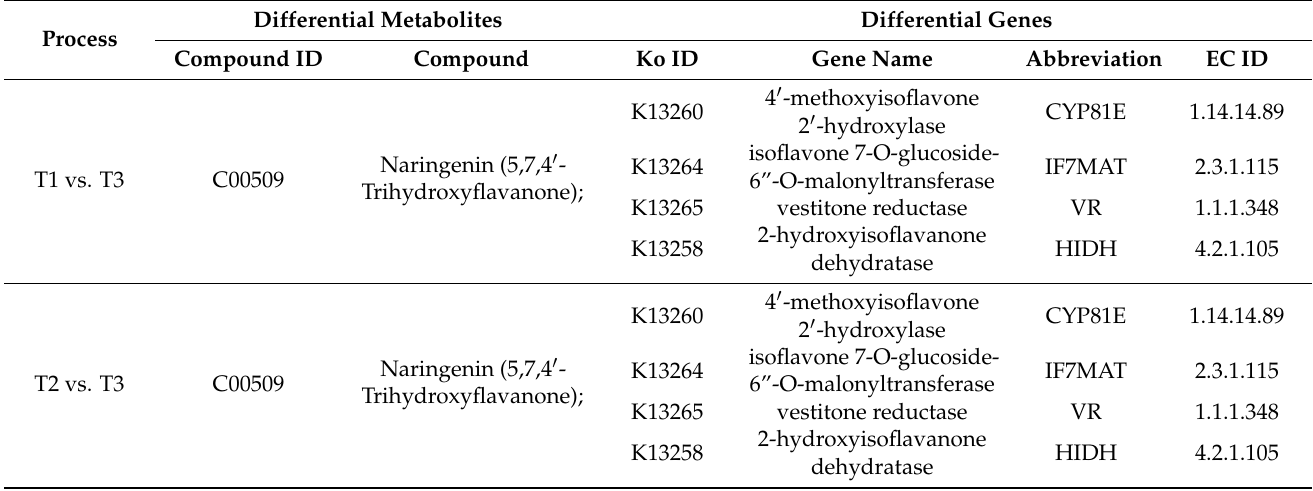
Table 3. Differential metabolites and genes in isoflavone biosynthesis